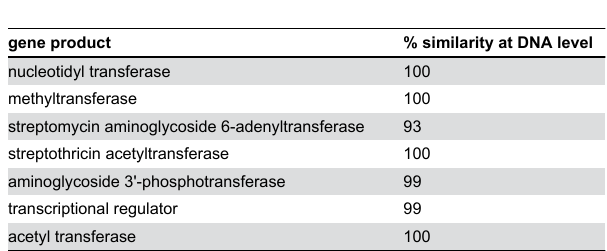
Tabel 1. Genes on the S1800 and S1805 novel S. aureus plasmid and present as a unit in Streprococcus mitis